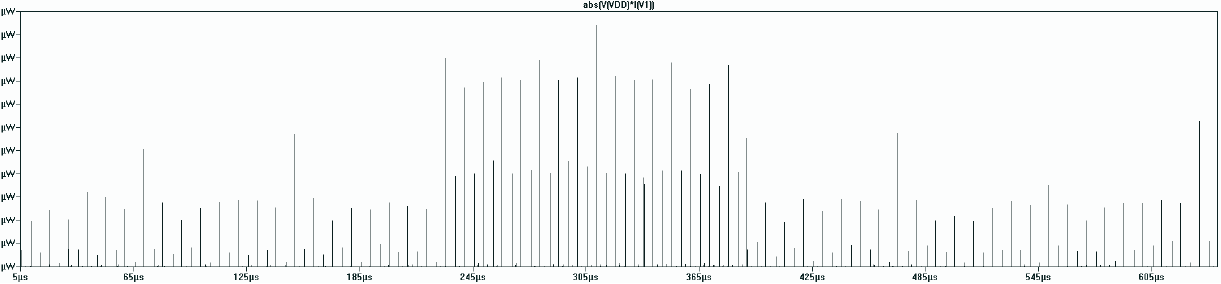
Figure 4. LTSpice power consumption simulation. Power dissipation is concentrated around the internal clock